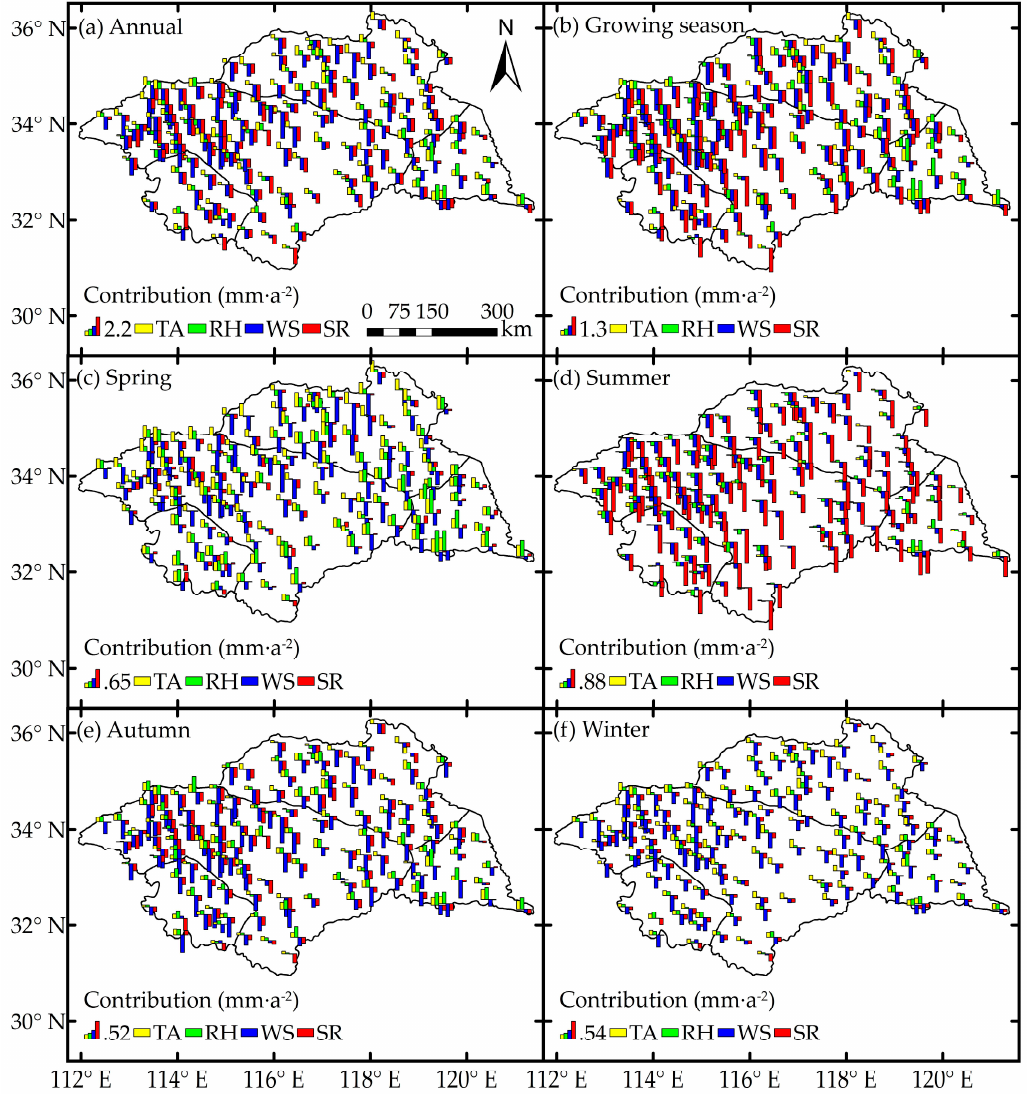
Figure 8. Spatial distribution patterns of contributions of climate factors to ET ref in ( a ) annual; ( b ) growing season; ( c ) spring; ( d ) summer; ( e ) autumn; and ( f ) winter during 1961–2014 in the HRB.